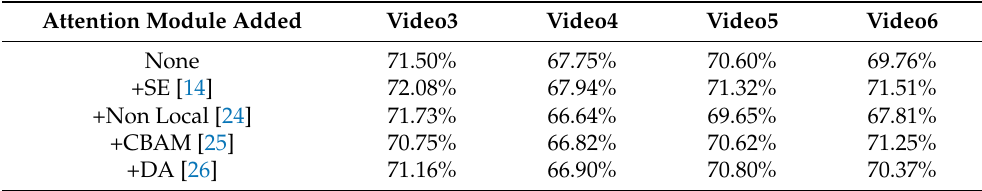
Table 6. The influence of different attention modules on the performance of the rough detection